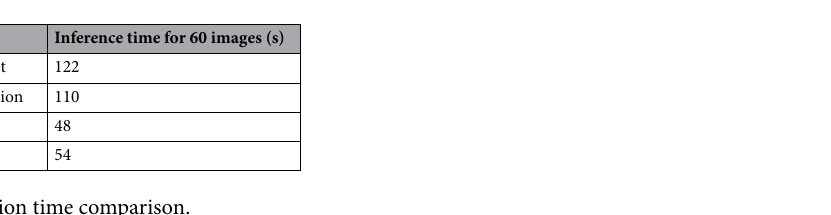
Table 4. Execution time comparison.